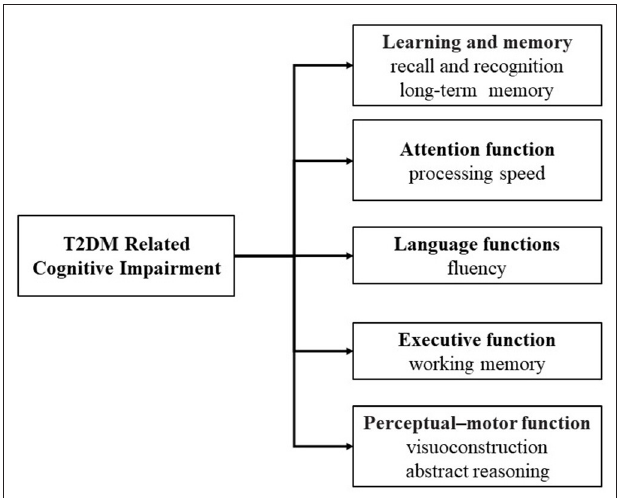
FIGURE 2 | Domains of T2DM related cognitive